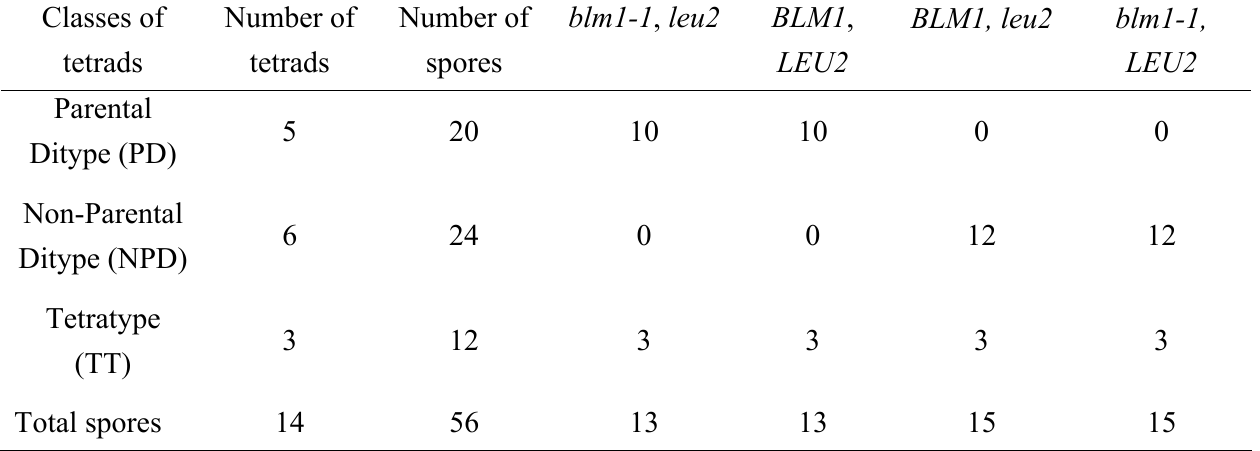
Table 4. Analysis of tetrad segregation of CM1457-79C ( blm1-1,leu2 ) x PS593/6H ( msh4 :: LEU2, BLM1 ). (The number of spores of each genotype is tabulated. Only results from four-spored asci